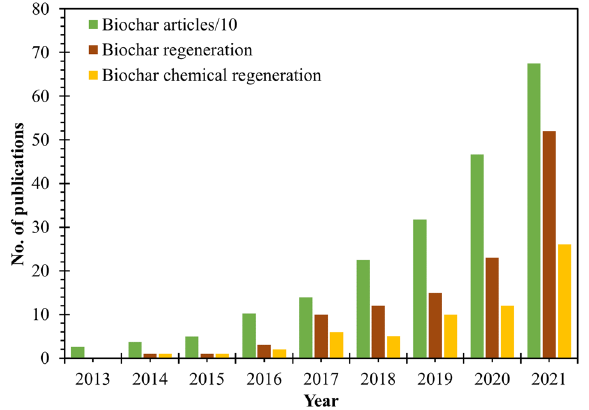
Fig. 3 Number of publications related to biochar extracted from Scopus database 29 . The number of papers presented research about biochar is extracted by searching “ biochar ” and “ wastewater ” in title, keywords, and abstract. Word :regeneration ” is added to extract the number of papers discussing regeneration. This word is replaced by ‘ chemical regeneration ’ to have the number of biochar papers having a chemical regeneration method. Overview of the published papers about biochar with emphasis on the chemical regeneration